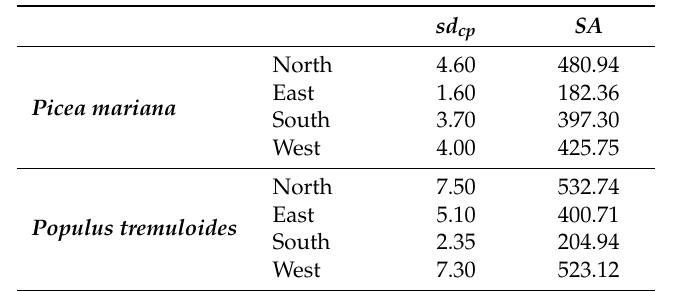
Table 3. Sapwood depth ( sd cp ) and sapwood cross-sectional area ( SA ) of a Picea mariana tree ( DBH = 38 cm) and a Populus tremuloides tree ( DBH = 30.11). Sapwood depth and cross-sectional area units are cm and cm 2